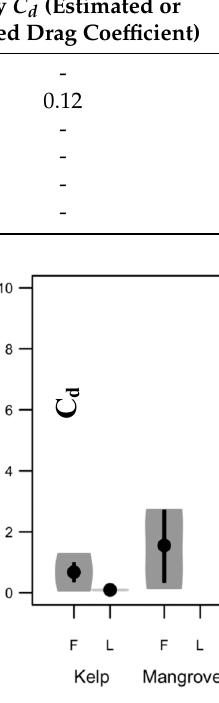
Figure 3. Plot of drag coefficients ( C d ) across kelp, mangrove, marsh, and seagrass habitats from lab (L) and field (F) studies. Width of the polygon indicates the kernel density, dots mark the median, and thick black bars mark the interquartile range (Reproduced with permission from [21], esa, 2013).